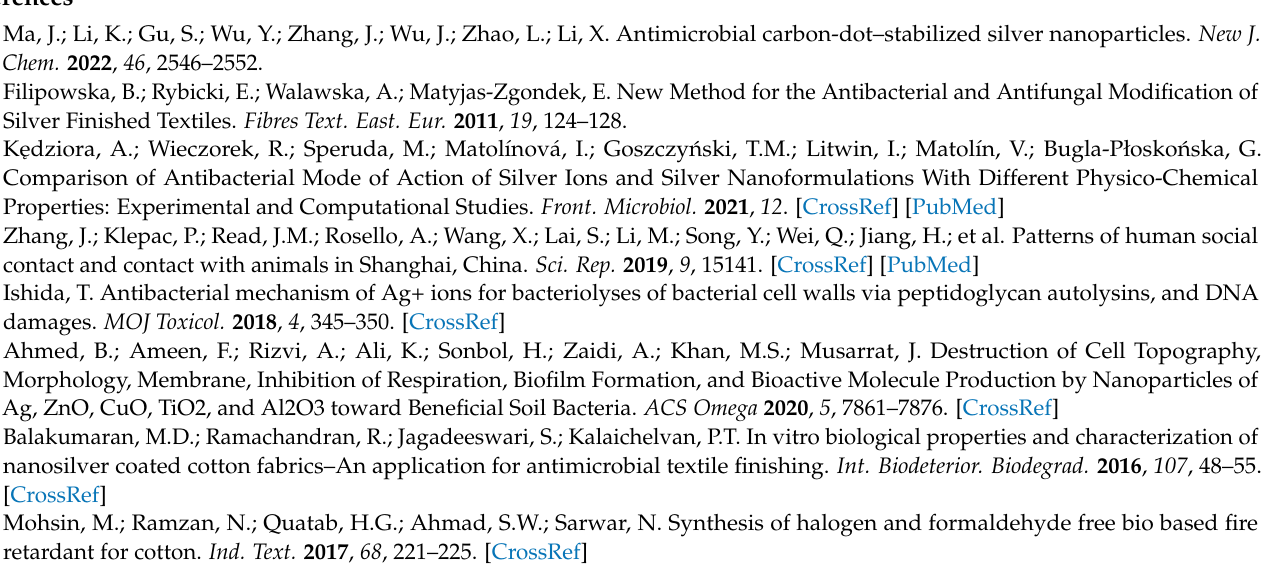
controls. Figure S1. Photographic images of incubated agar plates for each of the three repetitions; Figure S2. Estimated number of colonies in S. aureus ( − tive